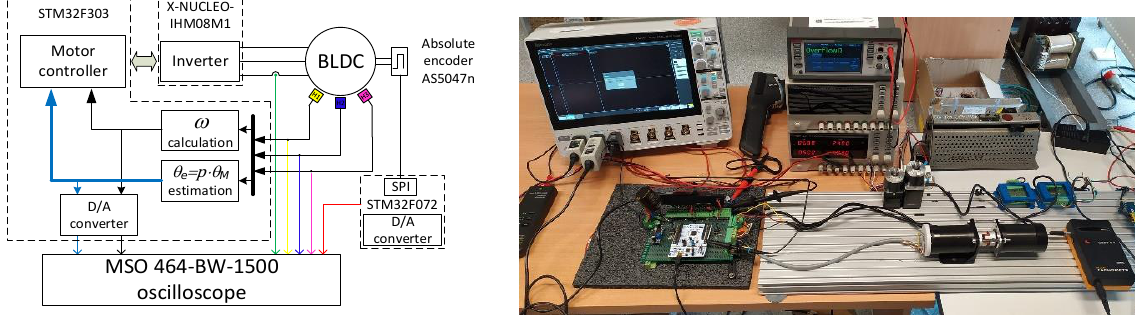
Figure 4. BLDC motor test stand for various control methods ( ω — calculated as a function of time measured between the successive changes in the Hall sensors).